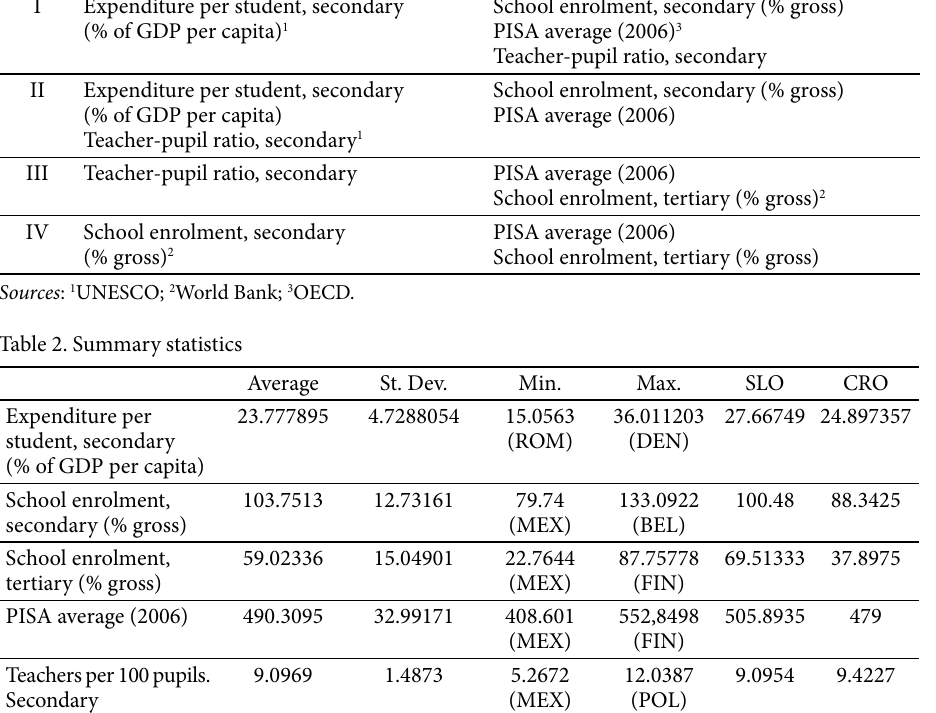
Table 1. Input and output/outcome set for the DEA Model